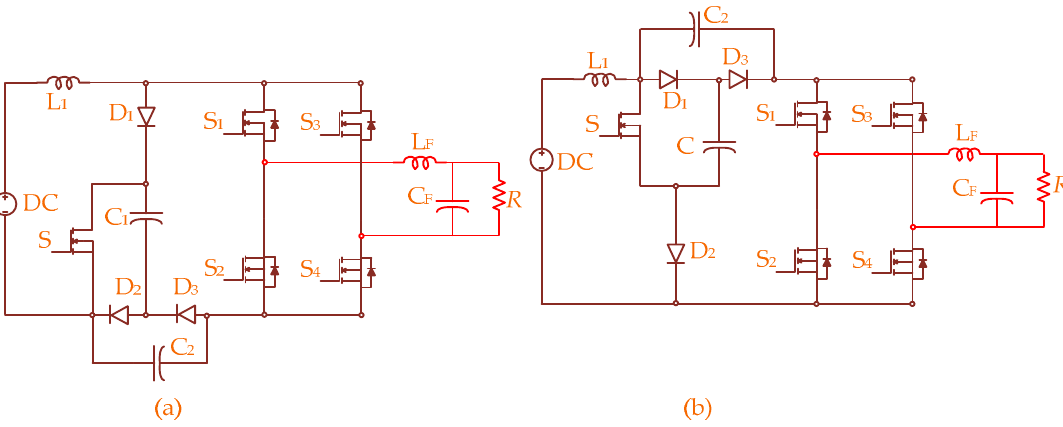
Figure 11. Switched-capacitor based qSBI topologies (SC-qSBI) ( a ) Type 1; ( b ) Type 2.